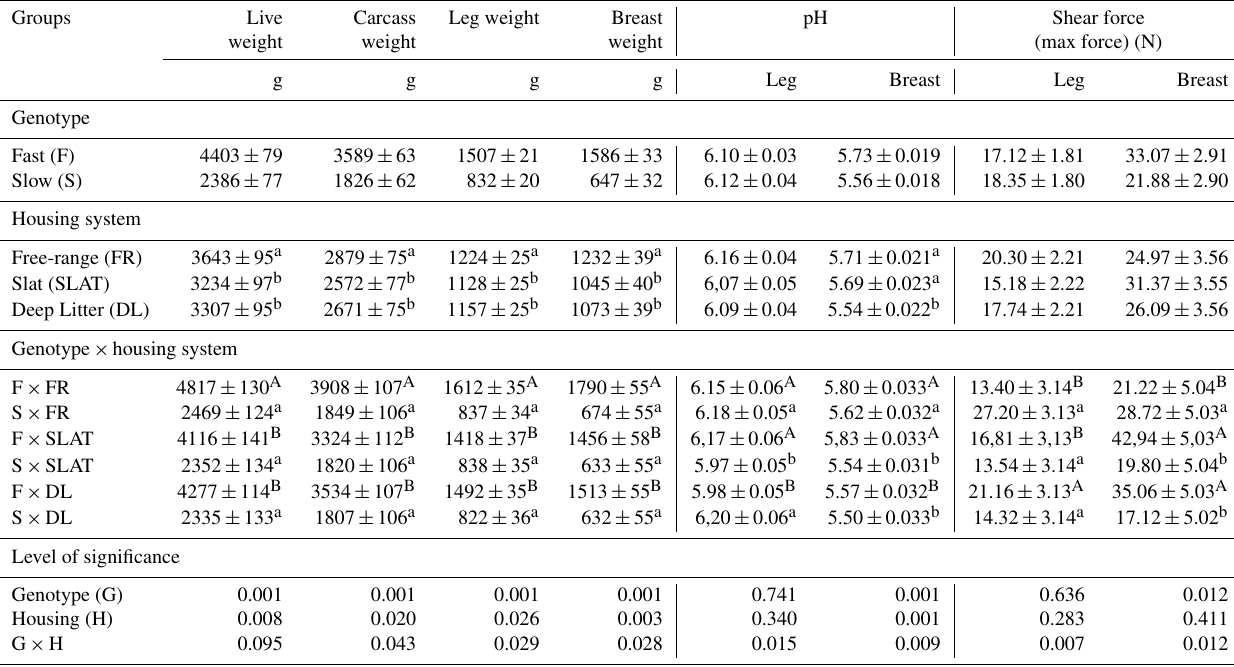
Table 1. Average live weight, carcass weight, and leg and breast weight; pH; and shear force values of meat samples of slow- and fast-growing broilers from different housing systems.